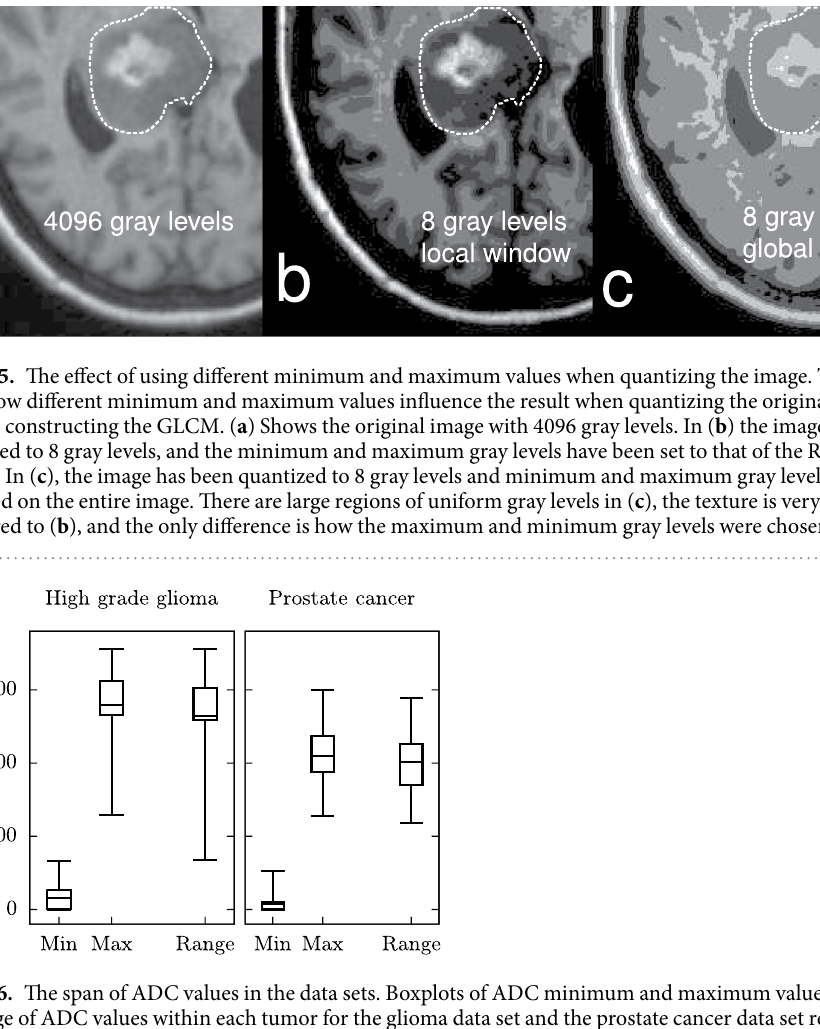
to ADC map construction. Energy is significantly affected by changes in the number of gray levels, quantization levels and noise, whereas correlation changes significantly only with resolution and image noise. Figure 2 is a heatmap showing the probabilities that all settings for a given parameter give the same texture feature values. Figure 2(a) shows the results from the glioma data set, and Fig. 2(b) shows the result from the pros- tate cancer datatset. The two leftmost columns in each heatmap show pre-processing steps when generating the GLCM, and column three to five in (a) and three to four in (b) show imaging settings. GLCM size has the largest effect on all texture features except for correlation in both data sets, and cluster shade and information measure of correlation 1 in the prostate data set. The quantization method has a significant effect on most features in both